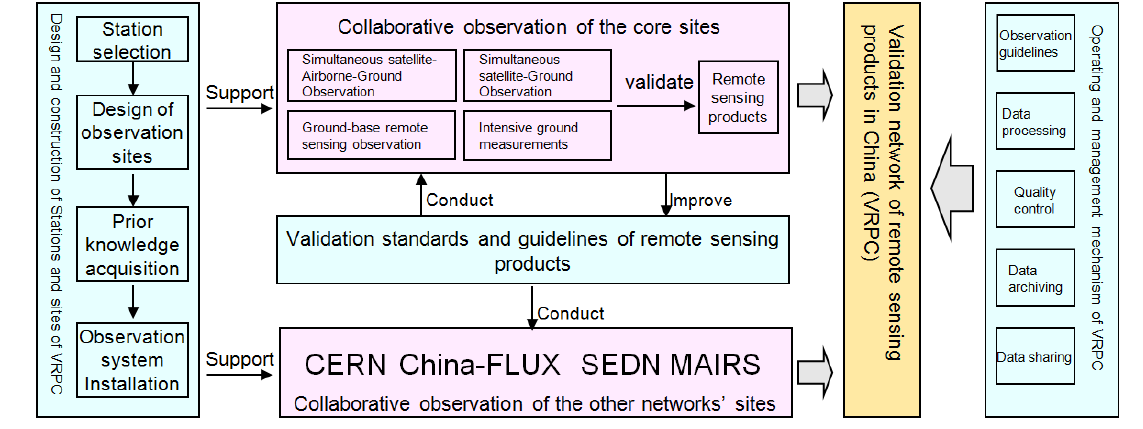
Figure 1. Frame of